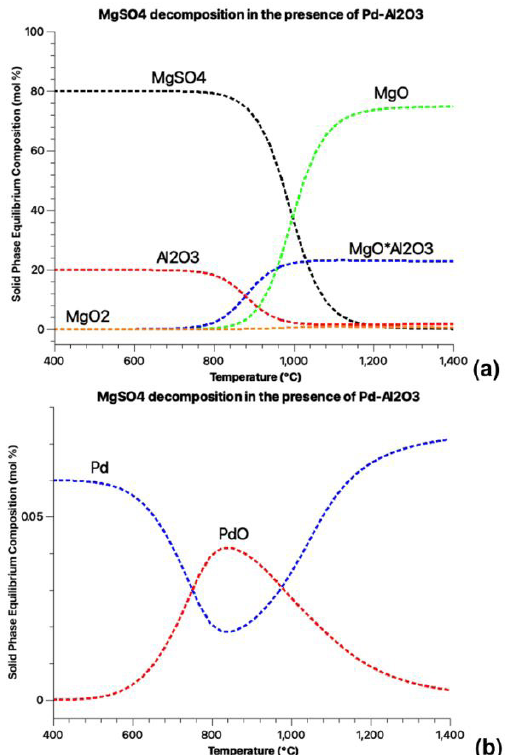
Figure 1. Solid-phase equilibrium composition as a function of temperature: (a) magnesium and aluminum bearing species; (b) palladium bearing